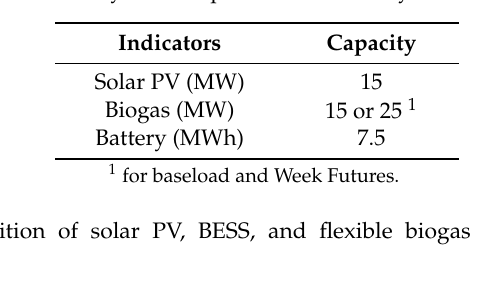
Table 1. Parameters of the case study for the operations of the Day-Ahead and Week Futures markets.